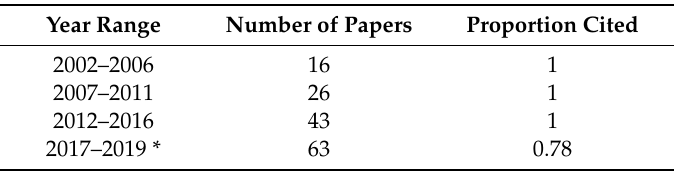
Table 3. Proportion of TNR papers cited by year of